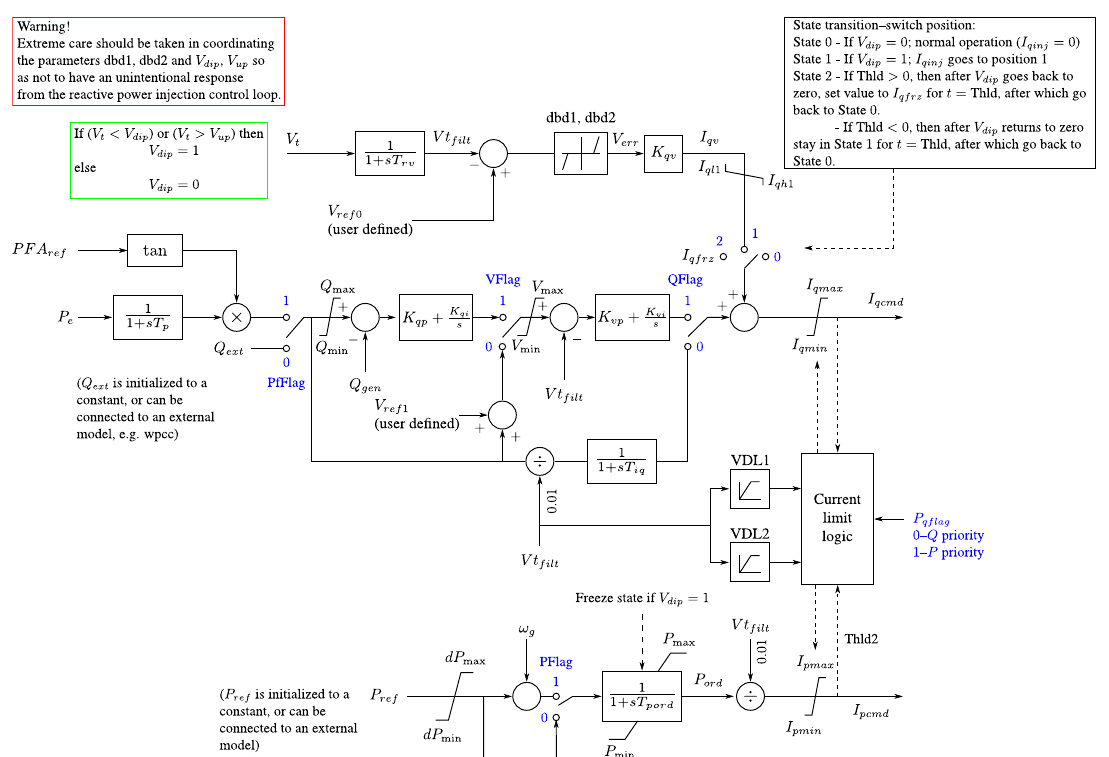
Figure 6. Second-generation PV model: electrical controller model.